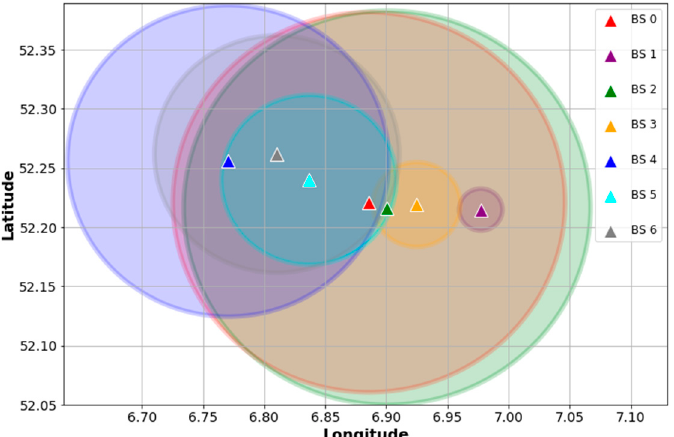
Figure 3. Coverage approximation of BS based on data points, assuming isotropic radiation, and ideal propagation.